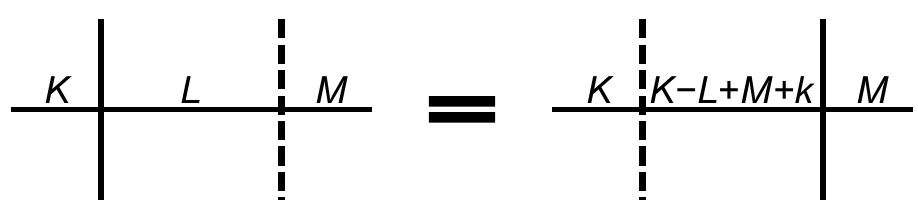
Figure 1 . Brane cartoon of the HW transition in (2.1). The horizontal direction denotes the direction 6, while the vertical direction denotes the directions of 3,4,5,7,8,9. The horizontal line indicates the D3-branes and the two different vertical lines (solid and dashed) are the two different 5-branes (the NS5-brane and the (1 , k ) 5-brane